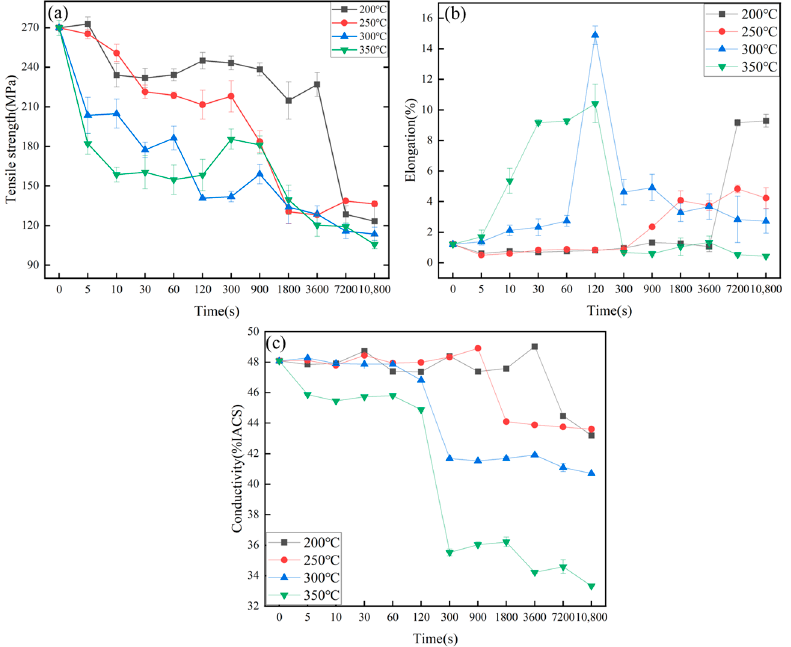
Figure 10. Properties of Pd/Al composite wires at different temperatures with annealing time: ( a ) tensile strength, ( b ) elongation, and ( c ) electrical conductivity. sile strength, ( b ) elongation, and ( c ) electrical